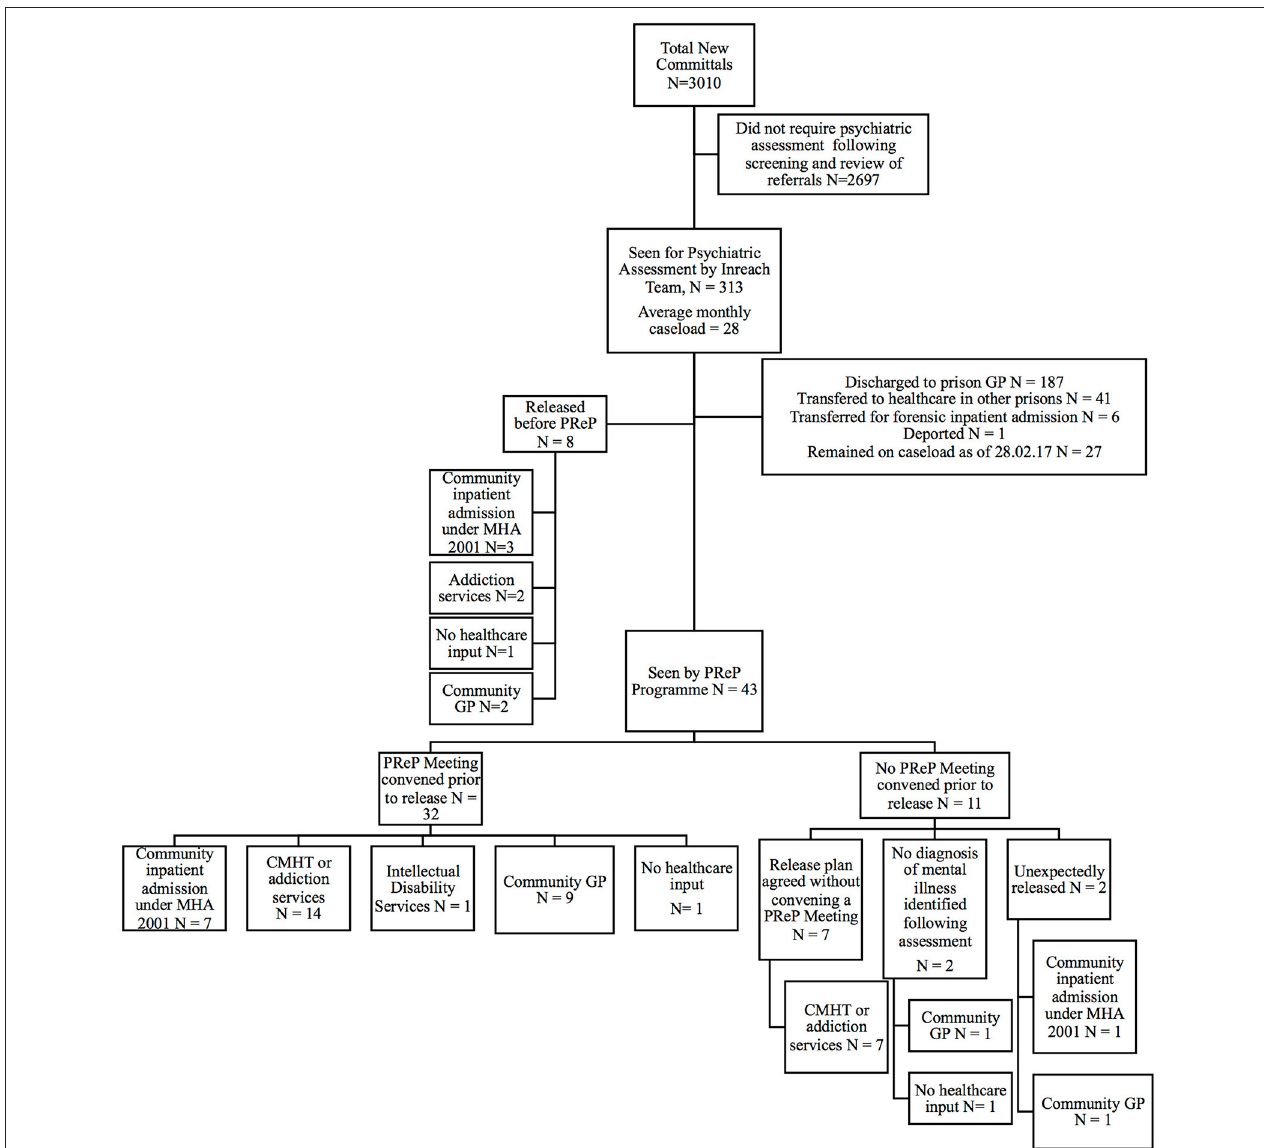
FIGURE 2 | Consort diagram displaying mental health outcomes on day of release for all those seen by the Mountjoy Prison Ireach Mental Health Service and PReP Programme from 1st March 2015 to 28th February 2017. PReP, Pre-Release Planning; CMHT, Community Mental Health Service; GP, general practitioner; MHA 2001, Mental Health Act